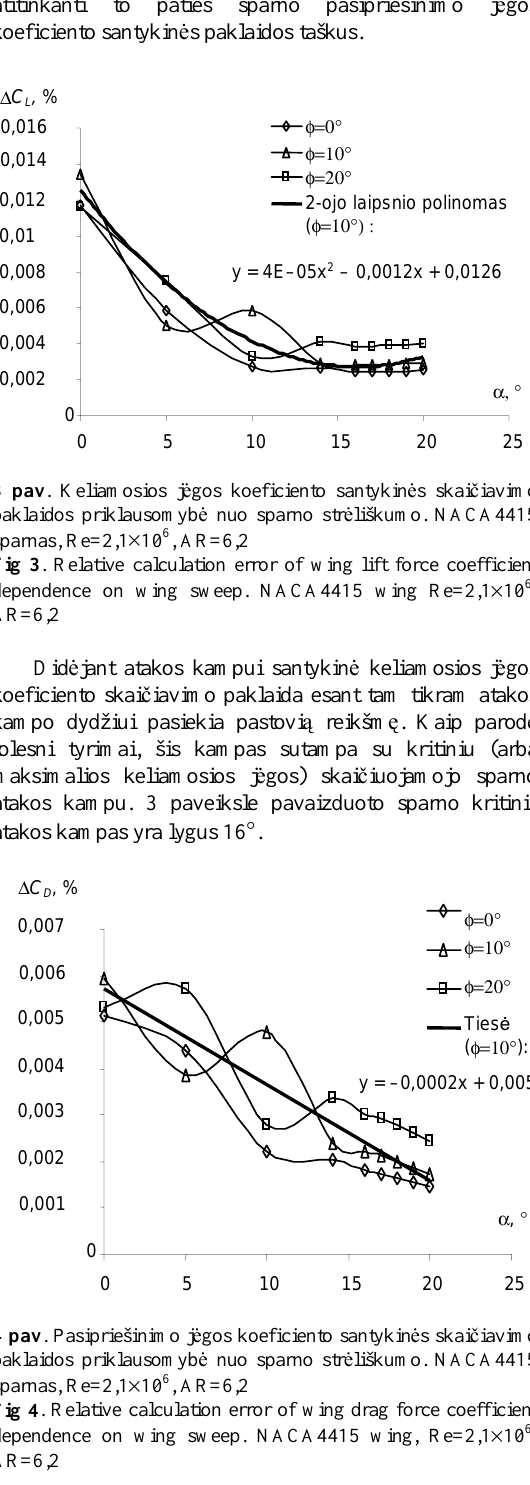
Fig 4 . Relative calculation error of wing drag force coefficient dependence on wing sweep. NACA4415 wing, Re=2,1 × 10 6 ,